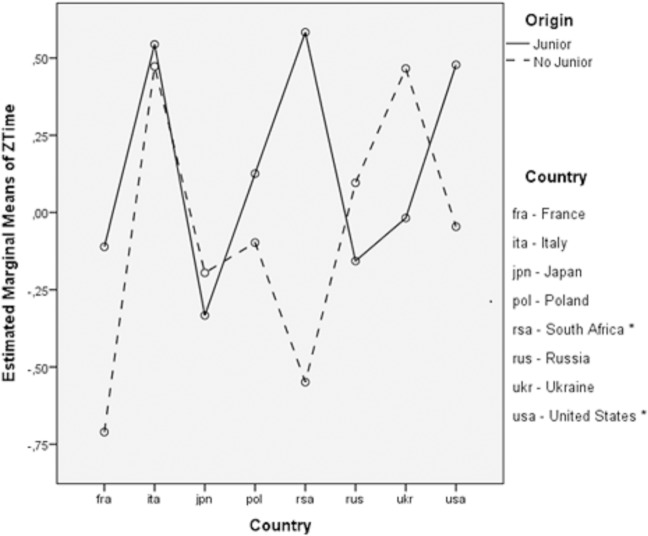
Profile plots for estimated marginal means of ZTime: Origin*Country.(*Significant differences at p < 0.05 between Junior and No Junior groups).